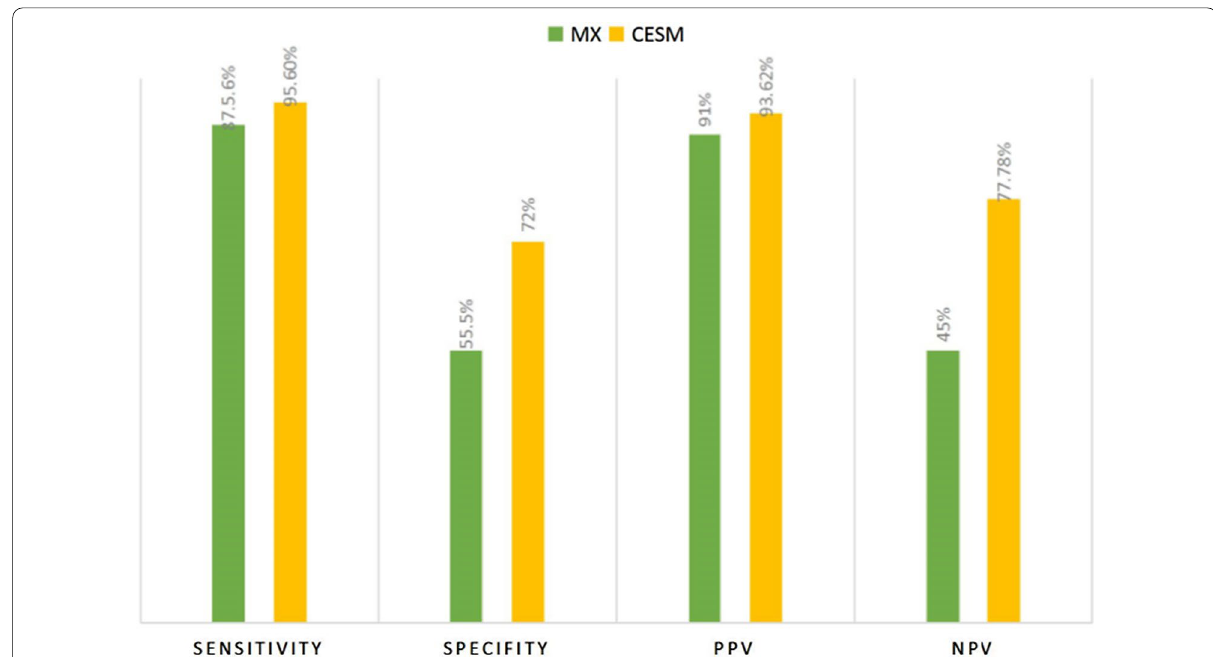
Fig. 4 The overall performance of CESM in comparison to